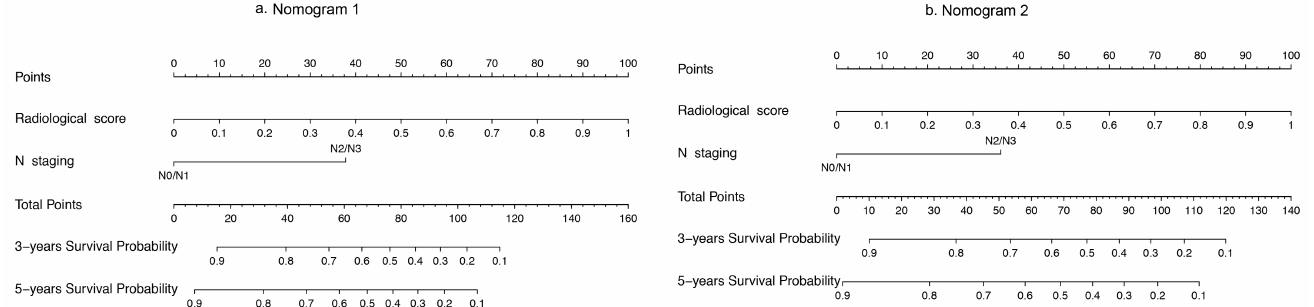
Figure 4. Time-dependent